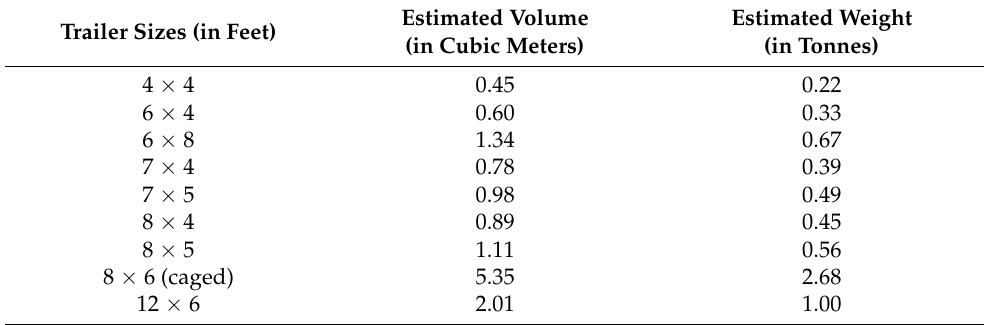
Table 3. Trailers sizes provided by survey respondents and conversion to cubic meters and